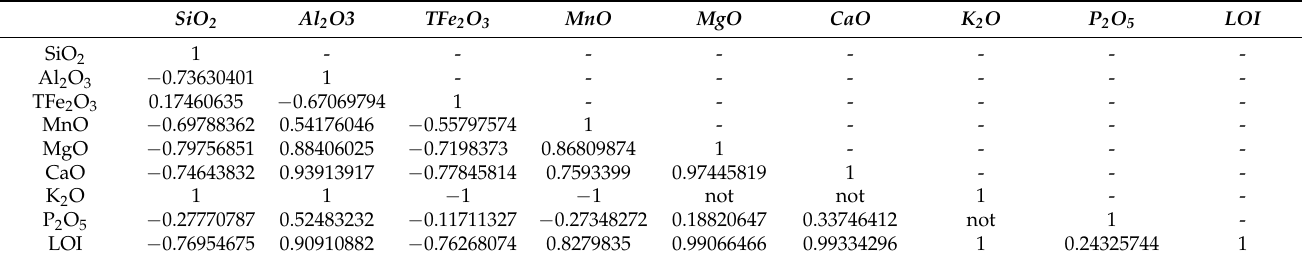
Table 3. Pearson’s correlation matrix for major element oxides of oxide-facies-BIF.